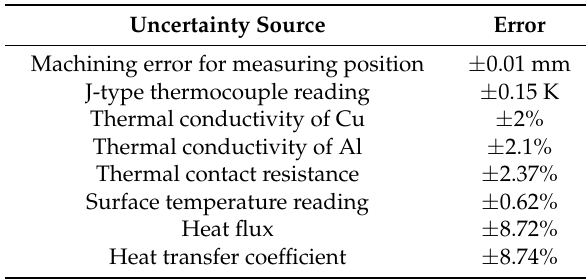
Table 1. Uncertainty sources and error